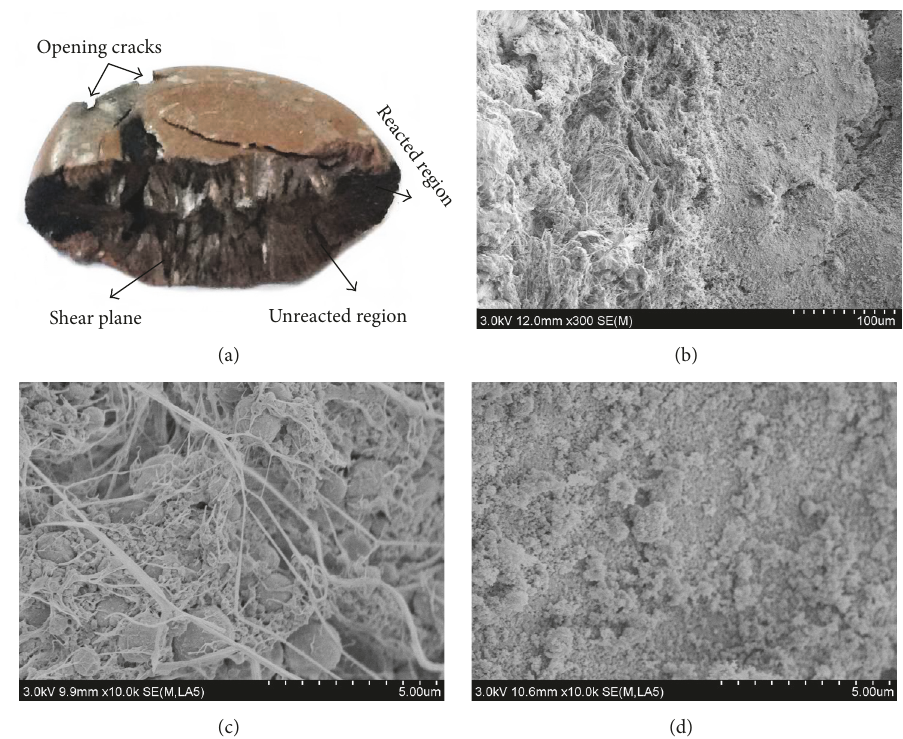
Figure 6: SEM photographs of the initiation region and specimen after reaction. (a) Specimen after reaction, (b) boundary of reacted region (right) and unreacted region (left), (c) unreacted region, and (d) reacted